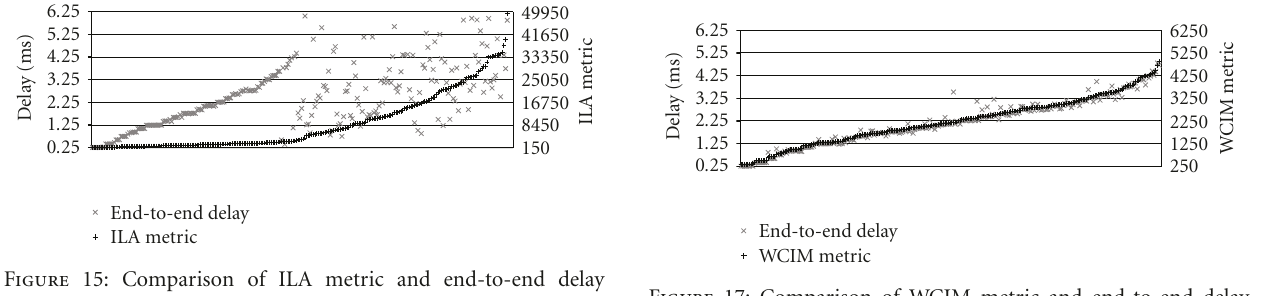
Figure 17: Comparison of WCIM metric and end-to-end delay variations ( f 6) . Table 6: Standard deviation of delay/metric ratio (expressed as a percentage of the